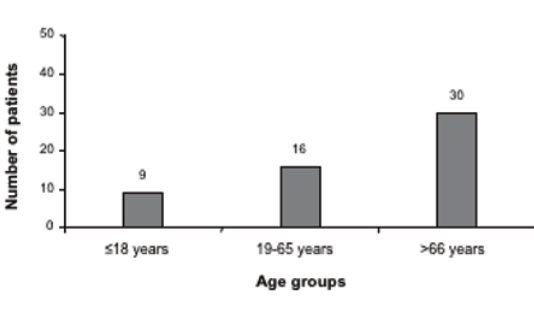
Figure 4. The prevalence of cancers in the herpes zoster and control group, the Clinic for Infectious Diseases UCH Mostar in the period from January, 1 st 2005 to December, 31 st 2010. (HZ–Herpes zoster, GEC –